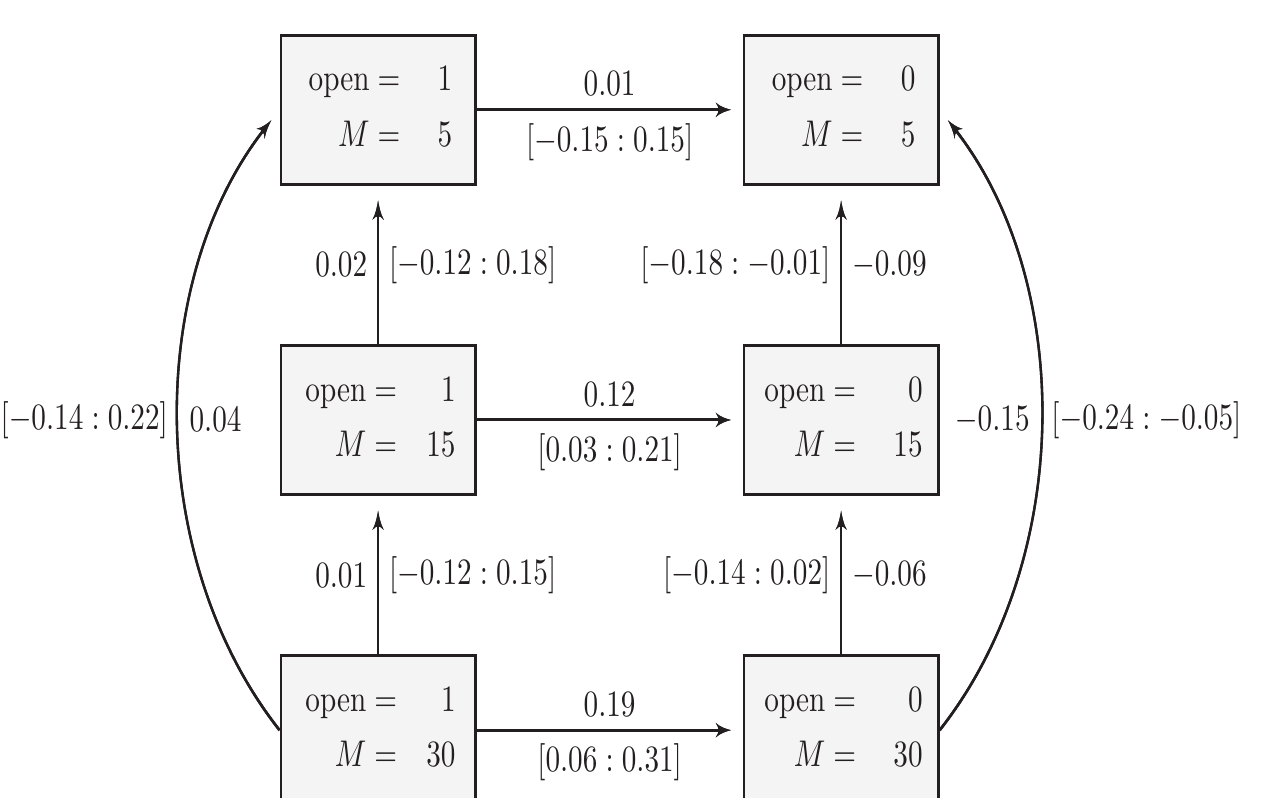
Figure 3. First-order interaction first